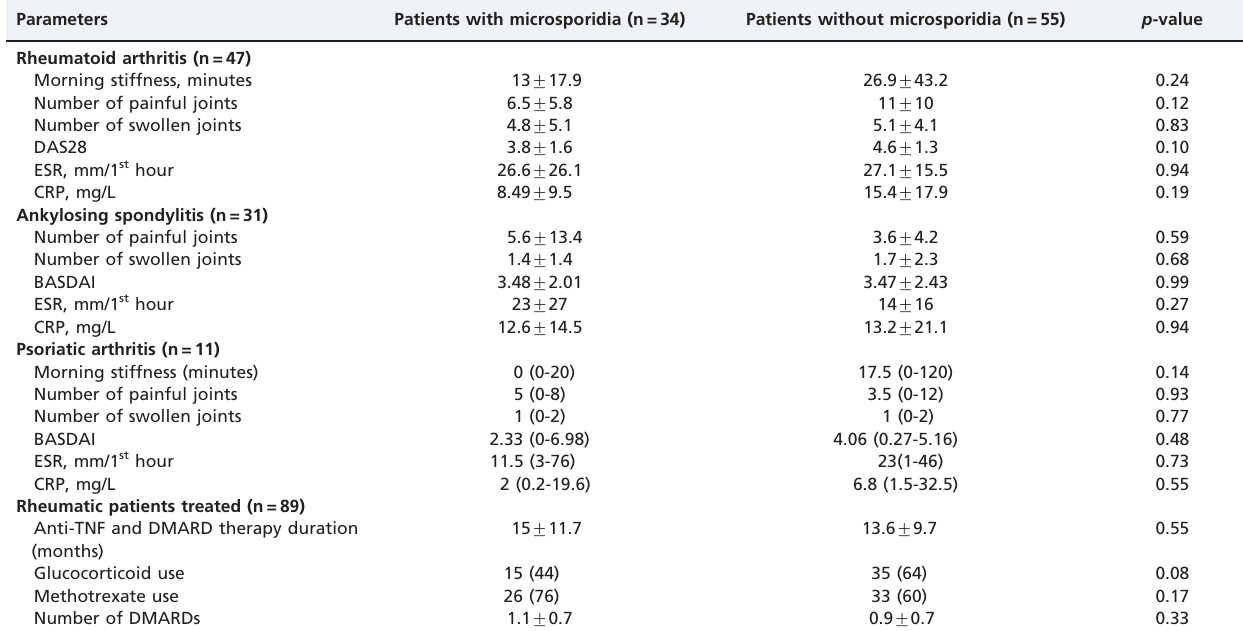
Table 2 - Disease activity parameters and treatments in patients with rheumatic diseases undergoing anti-TNF and DMARD therapies with and without microsporidia